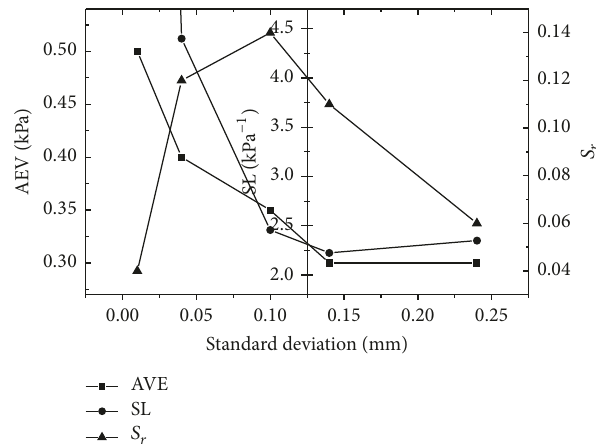
Figure 12: AEV, SL, and 𝑆 𝑟 versus standard deviation